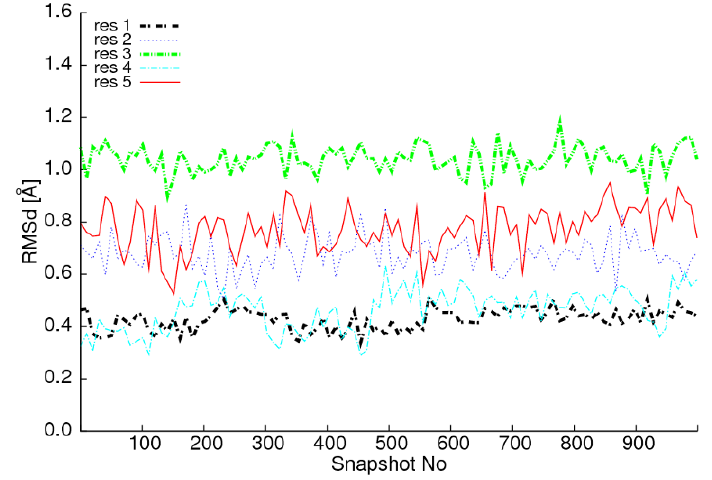
Figure 2. Plot of RMSd changes of DA-DA during unconstrained